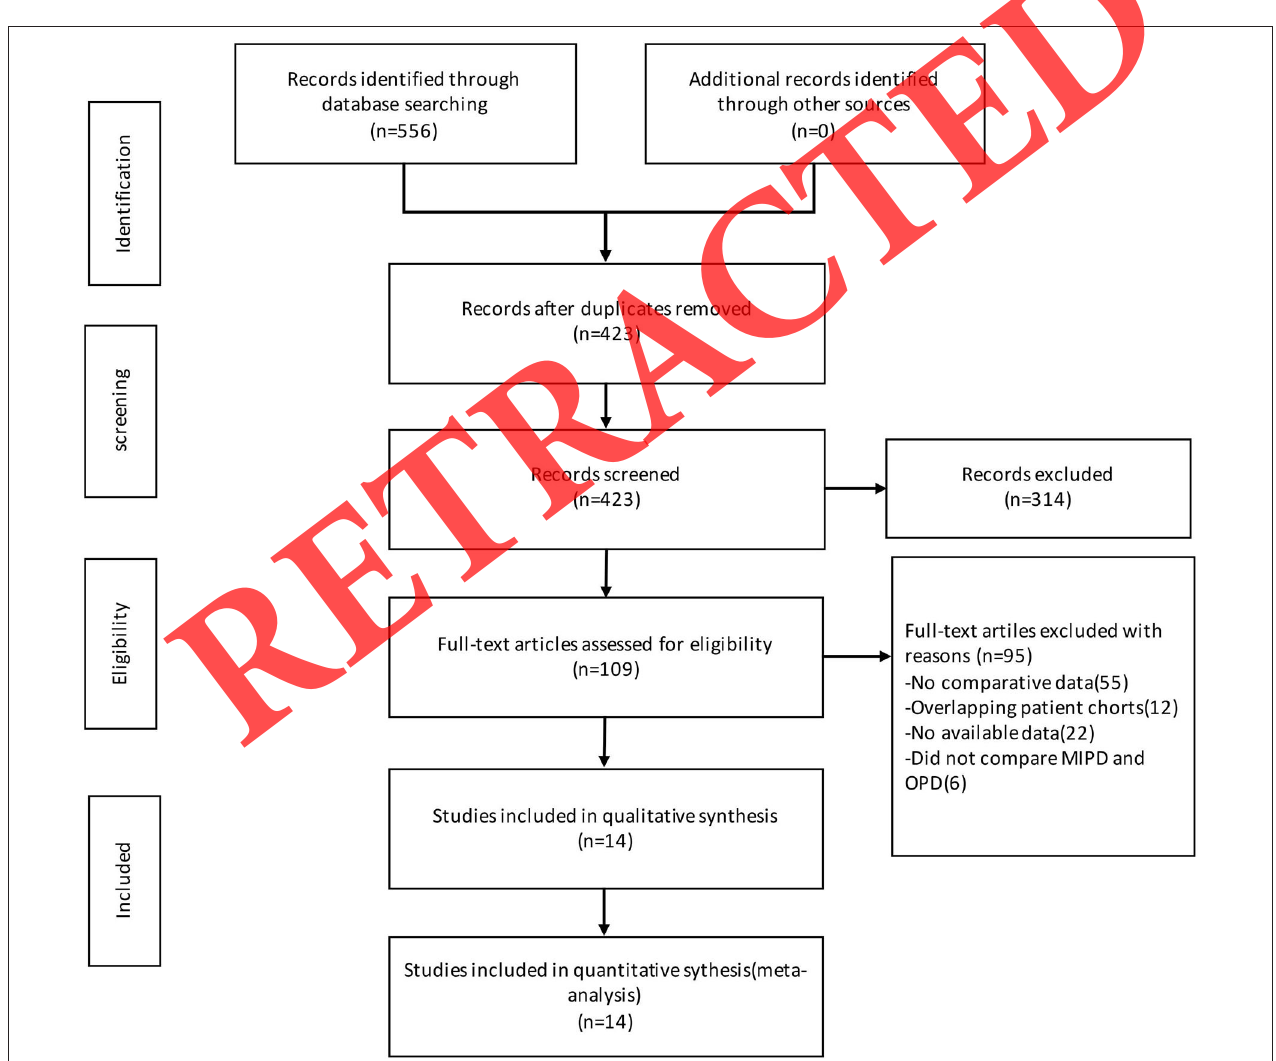
FIGURE 1 | Flow chart of study identification and